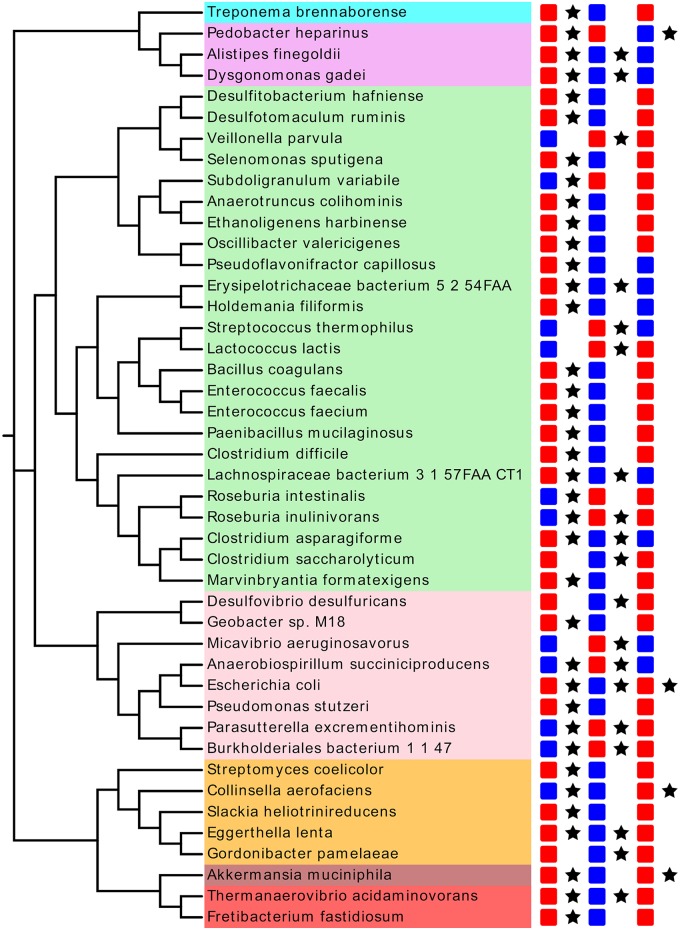
Bacterial species changes during weight loss intervention.Cladogram (based on 16S sequences) displaying the most abundant species from genera influenced by the intervention. Significant changes between T0 and T3 (left column of squares), between T3 and T6 (middle column), and between T6 and T24 (right column) are indicated by a star(p < 0.05). Blue squares indicate a decrease, red an increase in abundance. Species are colored according to the phyla they belong to (blue: Spirochaetae, pink: Bacteroidetes, green: Firmicutes, light pink: Proteobacteria, orange: Actinobacteria, brown: Verrucomicrobia, red: Synergistetes). This tree was created using the free software EvolView [27].